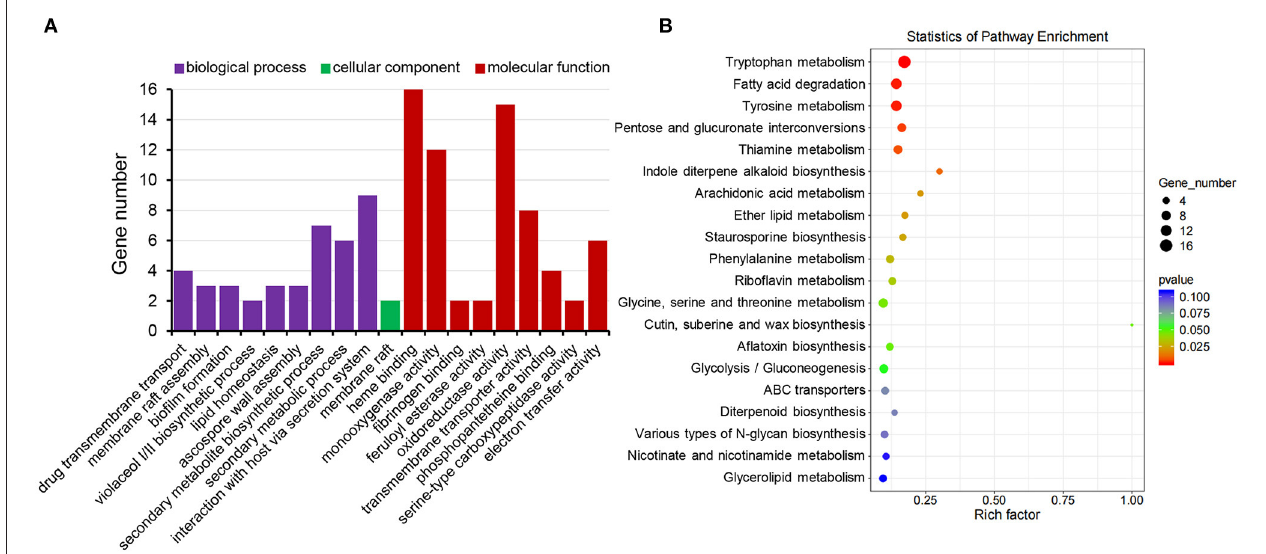
FIGURE 9 | Functional classification of MoRCN1 regulated genes relevant to Ca 2 + induction. (A) Gene Ontology terms of biological processes, cellular components, and molecular functions enriched in MoRCN1 regulated genes related to Ca 2 + induction. (B) KEGG analysis of enriched in MoRCN1 regulated genes related to Ca 2 +